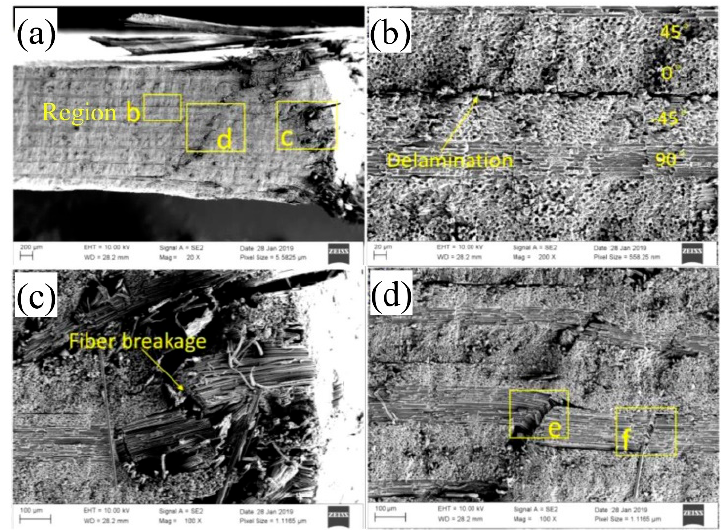
Figure 9. Scanning results of SEM around the hole at B [13] (( a – d ) region).